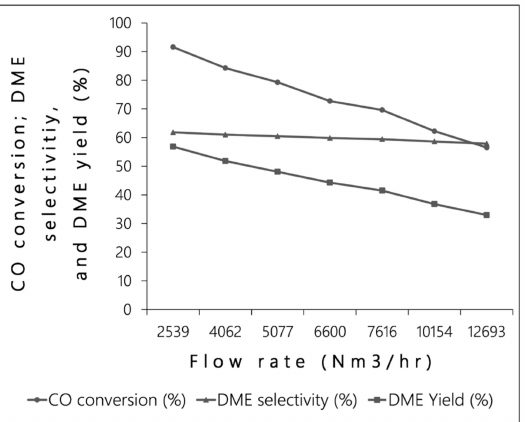
Figure 5. Influence of the flow rate on CO conversion, DME selectivity, and DME yield.